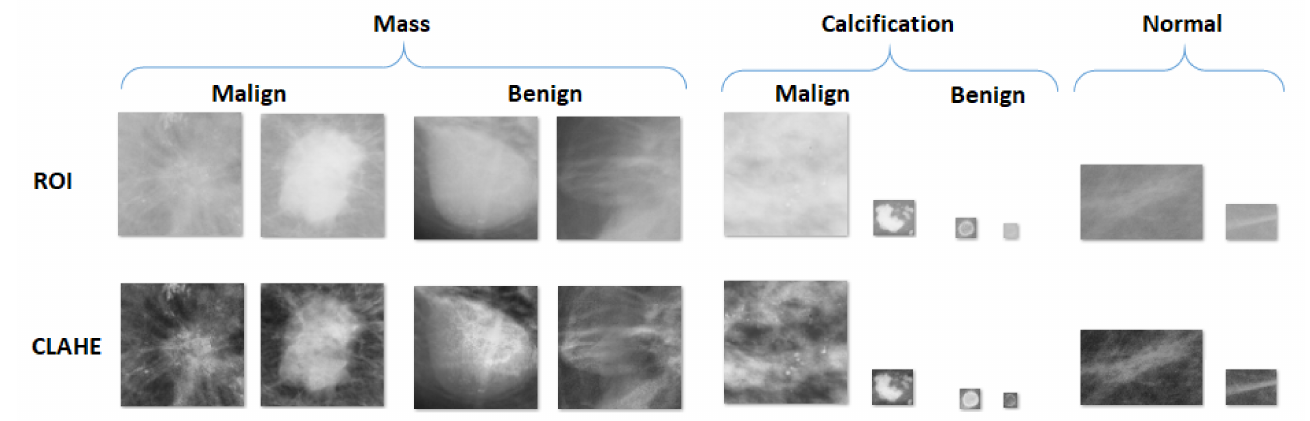
Figure 2. Regions of interest and CLAHE.